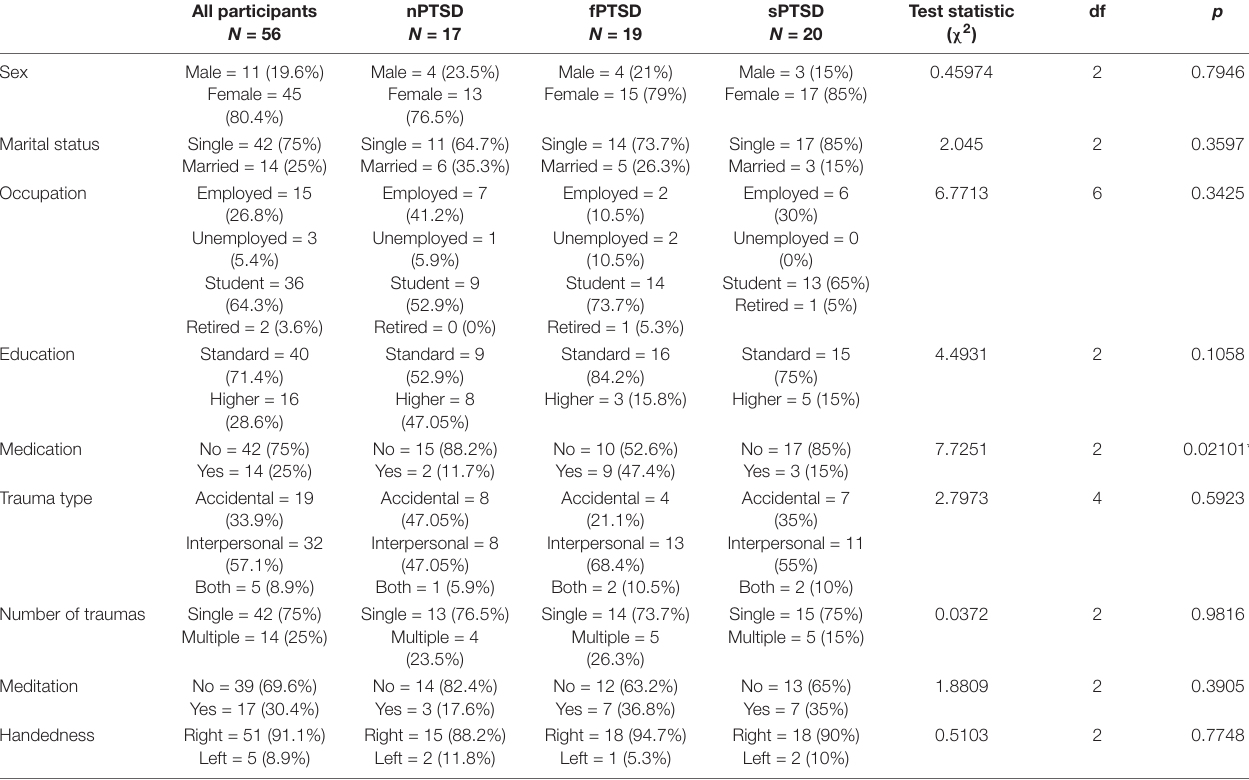
TABLE 2 | Characteristics, numbers, and percentages for all participants and each of the three PTSD groups; no PTSD (nPTSD), full PTSD (fPTSD), and subsyndromal PTSD (sPTSD) as defined in Section “Self-Report Measures”.